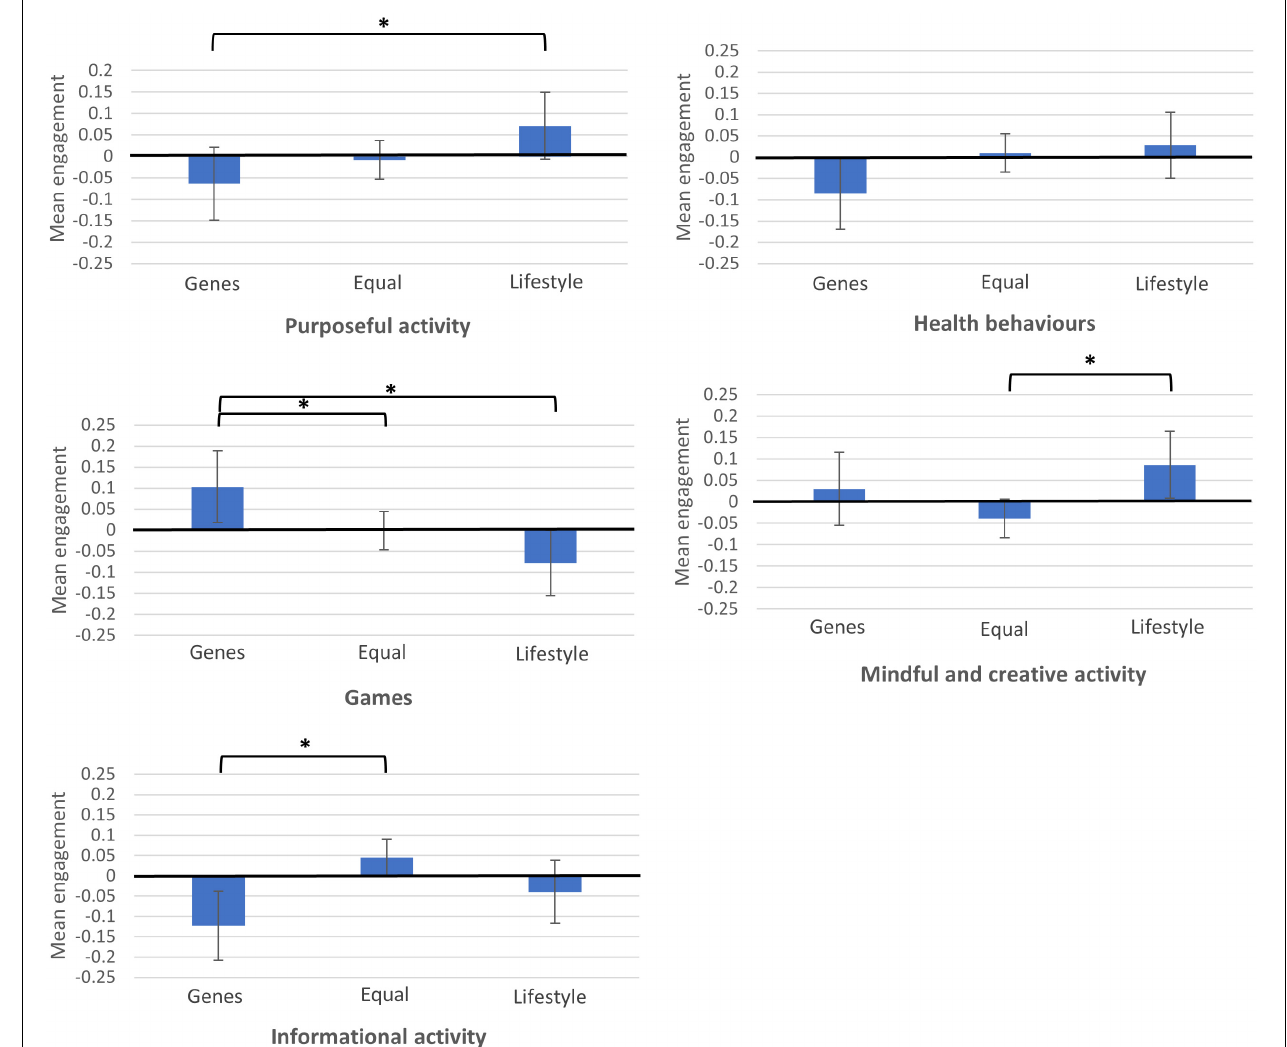
FIGURE 1 | Mean differences in engagement in five behaviours by determinants of cognitive skills. ∗ Mean differences are significant at p <